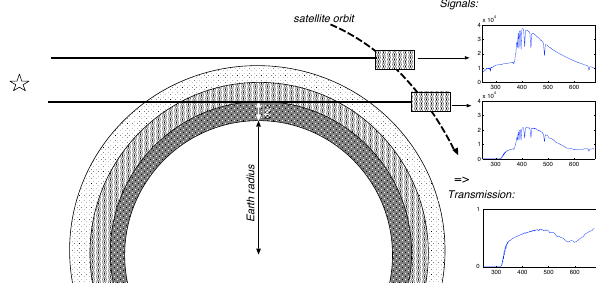
Fig. 1. The stellar occultation measurement principle of GOMOS. The horizontal transmission of the atmosphere is obtained by di- viding the attenuated stellar spectrum with the reference spectrum measured above the